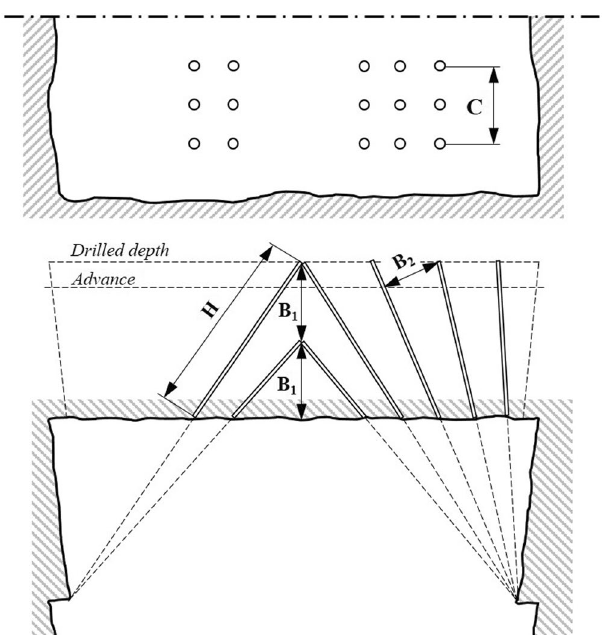
Figure 7. Typical V-cut used in underground mining 10 .